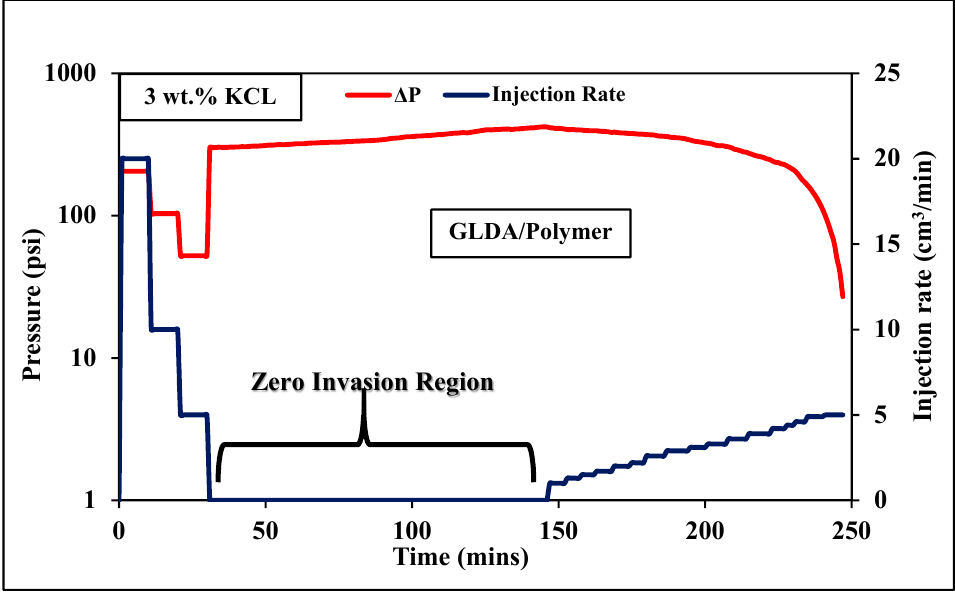
Figure 12. Coreflooding data for GLDA-AMPS polymer solution.